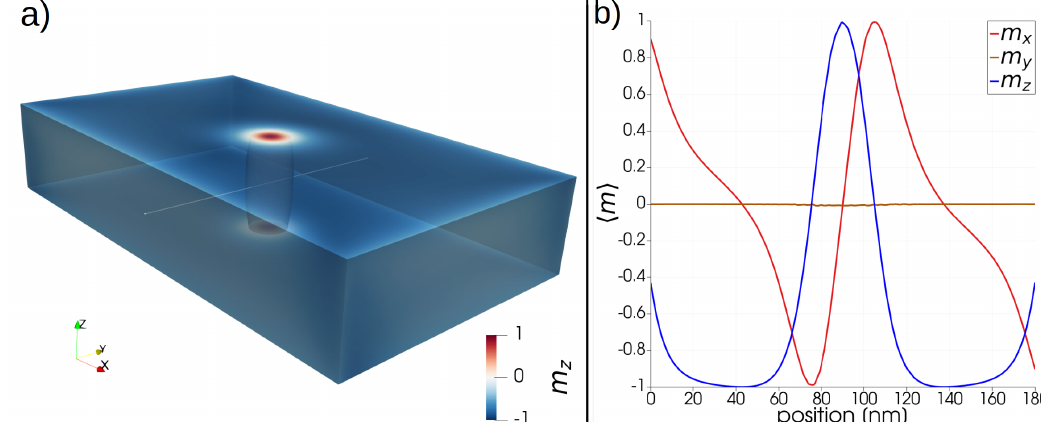
Figure 2. ( a ) A single magnetic skyrmion in a 60nm thick platelet, stabilized by a 650mT field, can form as a metastable state. The skyrmion is located precisely at the center of the thin-film element. The cylindrical shape in the middle is the m z = 0 isosurface, which represents the core region of the skyrmion. ( b ) The normalized magnetization components along a central cutline—oriented parallel to the y direction and shown as a grey line in panel ( a )—display the profile of the skyrmion. From the distance between two consecutive zero values of m z , we obtain the skyrmion core diameter to be 30nm. The Bloch character of the skyrmion is evidenced by the antisymmetric shape of the x (azimuthal) component and the vanishing y (radial) component of the